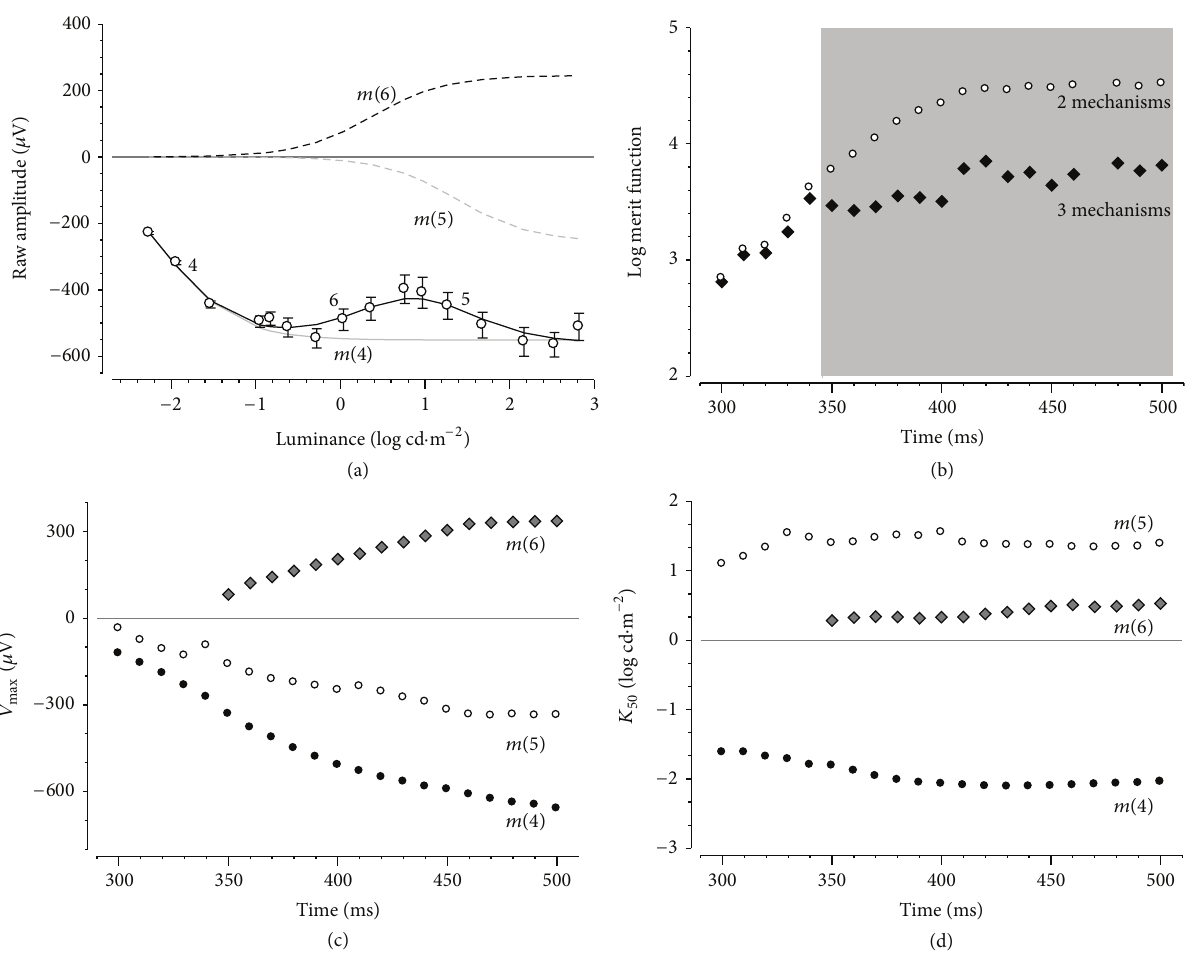
Figure5:ModelingcontributionstoratPIIafteralightstep.Average( ± SEM)amplitudesfollowingstimulusoffsetatafixedtimeof400msare modeled with threemechanisms. Thetwo negative components (4and5)aremodeled with two negativehyperbolic functions( m ( 4 )solidgrey line and m ( 5 ) dashes grey line), whereas the positive portion (6) is fit with a positive mechanism ( m ( 6 ) black dashed line). The solid black line represents the summation of the three hyperbolic functions fit to the raw data. (b) The merit functions show that three hyperbolic functions (filled) provide statistically better fit for fixed times > 340 ms (grey area, 𝑃 < 0.05 ) compared with two hyperbolic functions (unfilled). 𝑉 max (c) and 𝐾 50 (d) plotted as a function of fixed